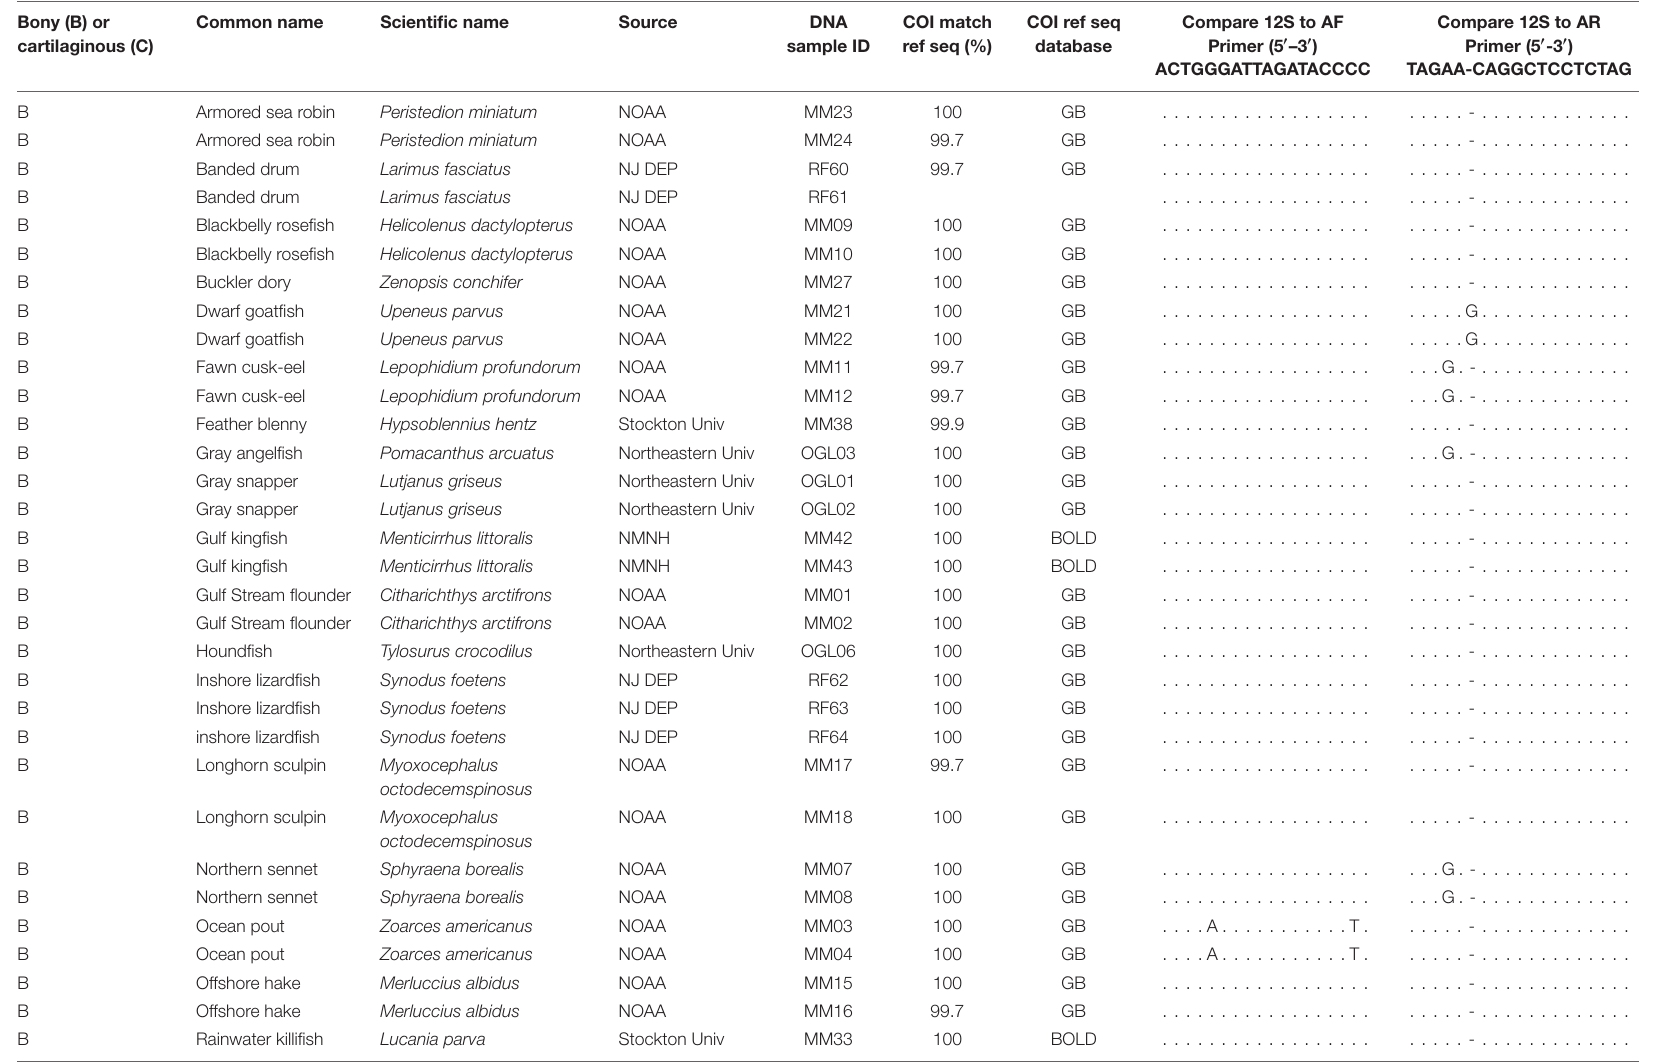
TABLE 1 | Fish tissue specimens analyzed in this report. Bony (B) or cartilaginous